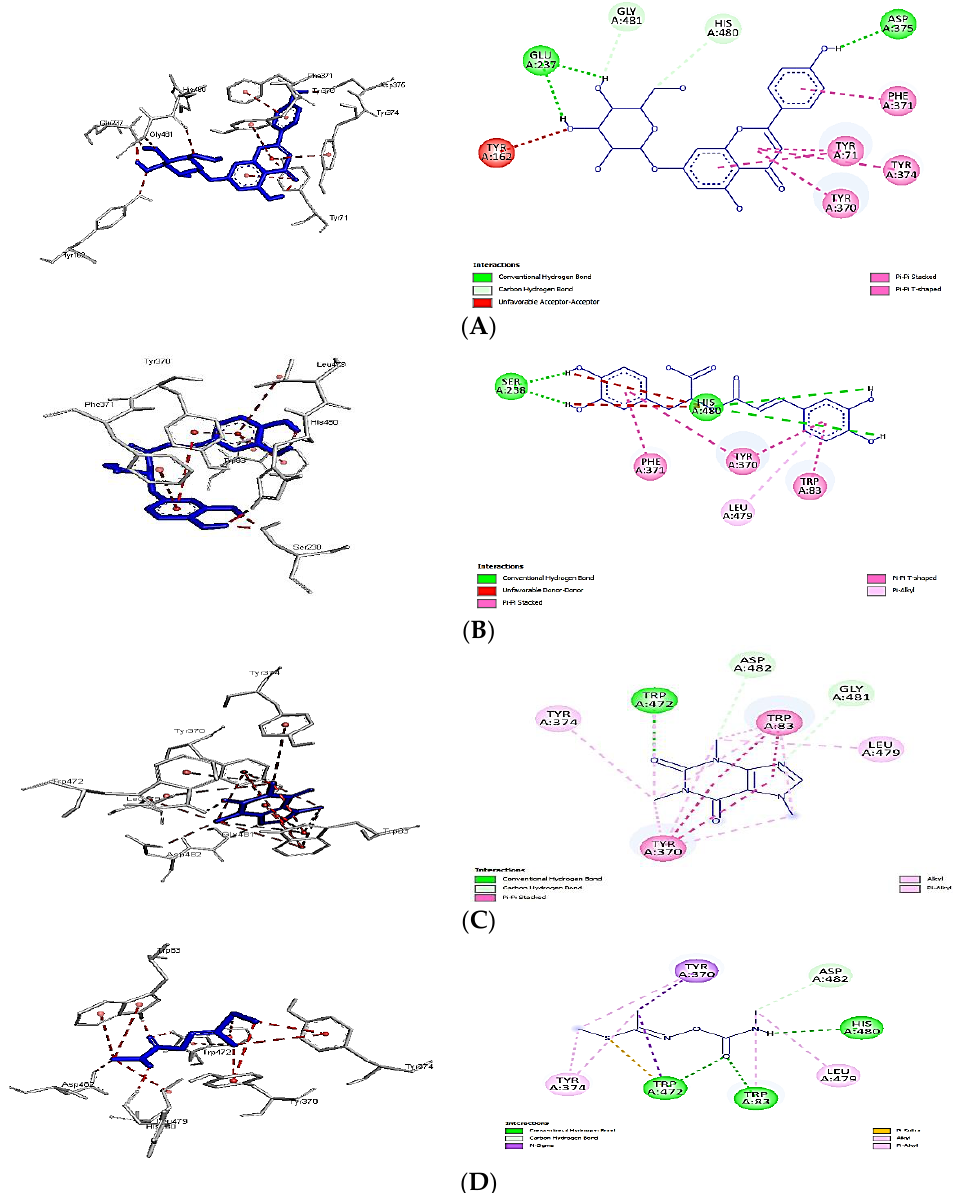
Figure 7. Interactions of ( A ) apigenin 7-glucoside, ( B ) rosmarinic acid, ( C ) caffeine, and ( D ) lannate (control) with the AChE receptor.